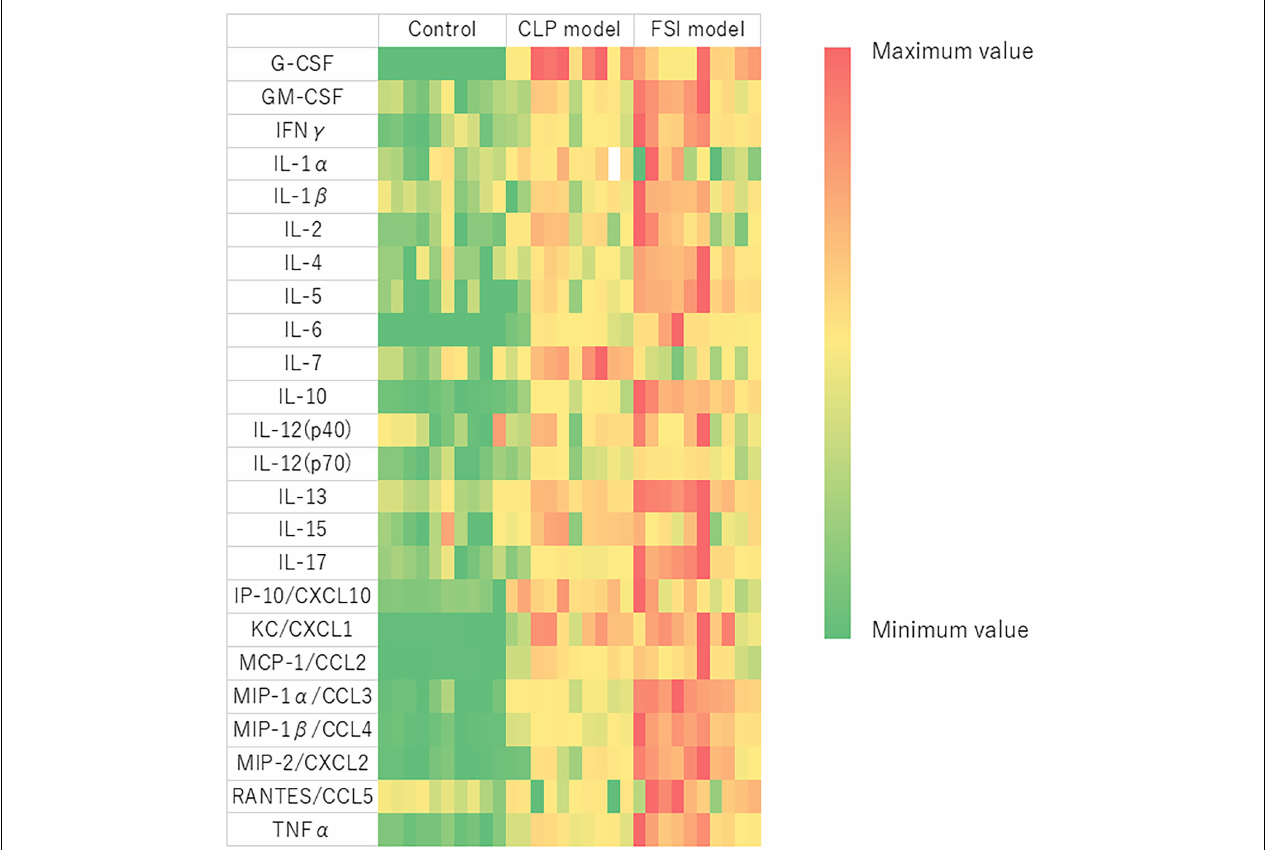
FIGURE 5 | Heatmap analysis of cytokine and chemokine measurements performed by multiplex analysis for FSI and CLP models. Blood was evaluated with samples taken 20 h after the onset of peritonitis. Heat map showing relative evaluation of cytokine and chemokine values. The maximum value of each variable is red, the minimum value is green, and the intermediate value corresponds to the gradation scale from red to green. G-CSF, Granulocyte-colony stimulating factor; GM-CSF, Granulocyte macrophage colony-stimulating factor; IFN γ , Interferon gamma; IL, Interleukin; IP, Interferon gamma-induced protein; CXCL, C-X-C motif chemokine ligand; KC, Keratinocyte-derived chemokines; MCP, Monocyte chemotactic protein; CCL, C-C motif chemokine; MIP, Macrophage inflammatory protein; RANTES, Regulated on activation, normal T cell expressed and secreted; TNF, tumor necrosis factor.